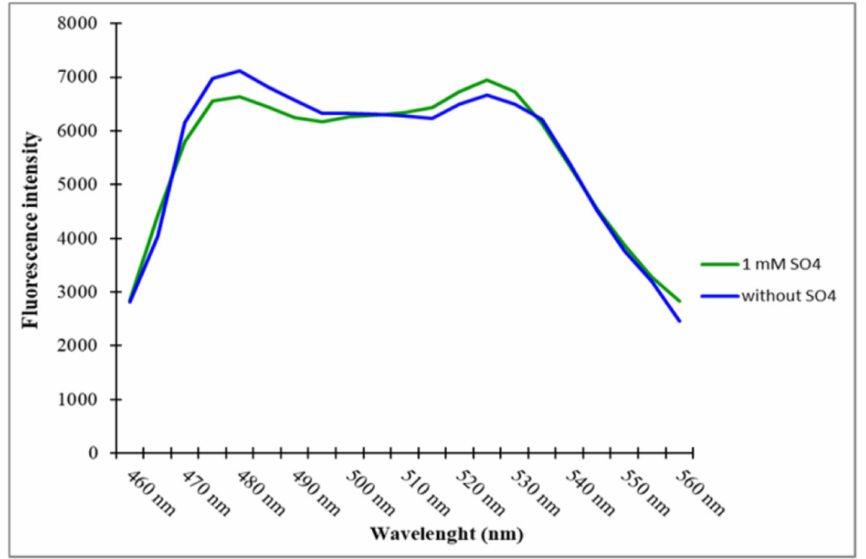
Figure 3. Spectral analysis of the sensor. Emission intensity was recorded in the absence and presence of 1 mM of sulfate after excitation of 435